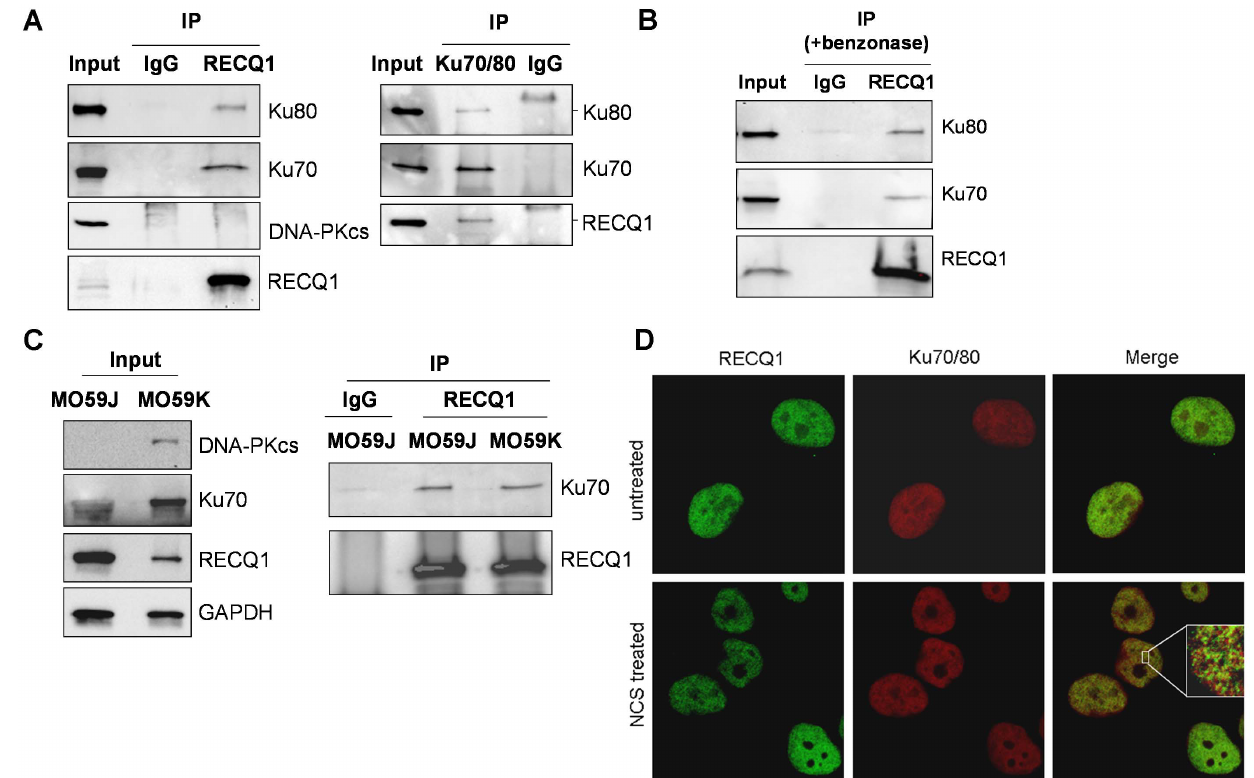
Figure 1. RECQ1 interacts with Ku70/80 invivo . A . Co-immunoprecipitation analysis of RECQ1 interaction with Ku70/80 using HeLa nuclear extracts. Immunoprecipitations (IP) with antibodies specific for RECQ1, Ku70/80 and preimmune IgG are indicated. Eluted proteins in immunoprecipitate were analyzed by Western blotting and are indicated. RECQ1 IP contained Ku70 and Ku80 subunits but DNA-PKcs was not detected. Reciprocal co-IPs of Ku70/80 also contained RECQ1. B. Association of RECQ1 and Ku70/80 is not mediated via DNA. RECQ1 antibody co- precipitated RECQ1 and Ku70/80 using benzonase-treated extract in IP reaction. C. RECQ1 interacts with Ku in DNA-PKcs deficient and proficient cells. Lysates of MO59J (DNA-PKcs deficient) or MO59K (DNA-PKcs proficient) cells were used for IP using RECQ1 antibody or IgG and analyzed by Western blotting as indicated. D . Immunofluorescence staining of endogenous RECQ1 and Ku70/80. HeLa cells grown on coverslips were either mock-treated or treated with NCS (100 ng/ml, 3 h). Cells were fixed and immunostained using a mouse monoclonal Ku70/80 antibody (1:200) and a rabbit polyclonal RECQ1 antibody (1:500). RECQ1 and Ku70/80 were visualized with Alexa Fluor 488- or Alexa Fluor 568-conjugated secondary antibodies, respectively, followed by confocal microscopy. Inset shows enlarged portion of the nucleus after NCS treatment; colocalization of RECQ1 (green) and Ku70/80 (red) in cells appears yellow in merged images. In all experiments, input corresponds to 5% of total protein used in IP reactions.